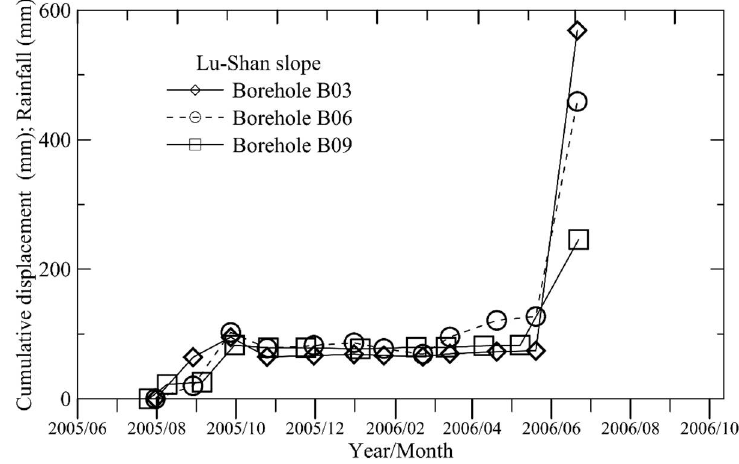
Figure 16. Comparison of cumulative slope displacements measured at various boreholes.